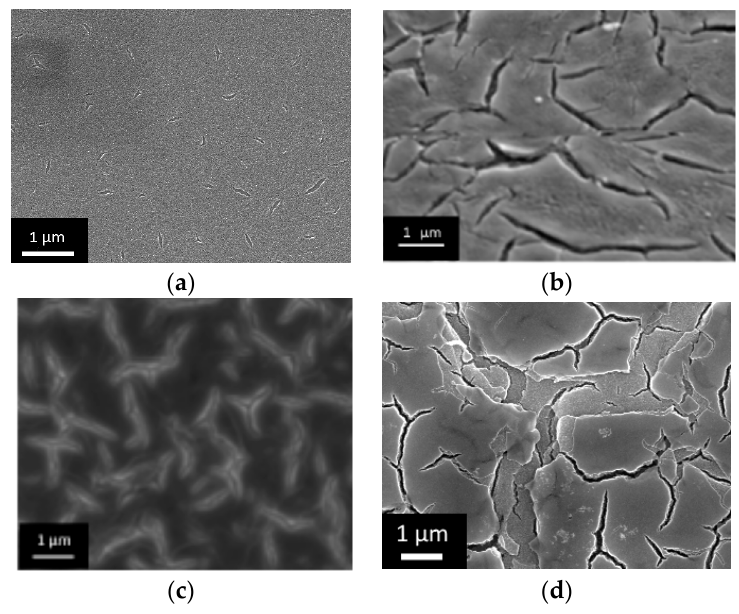
Figure 1. Electronic microphotographs of the textured TiO 2 xerogel films of various thickness obtained by shock drying freshly precipitated gel. ( a – d —2, 3, 4, 5 cycles of dip coating).